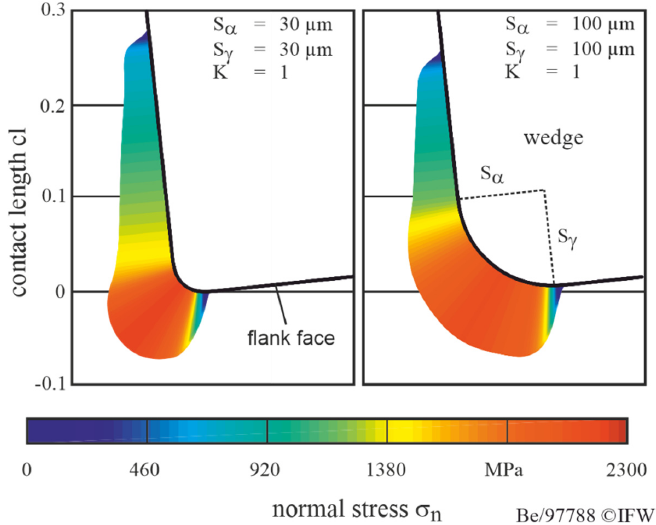
Figure 10. Simulated normal stress distribution depending on the cutting edge rounding during machining of